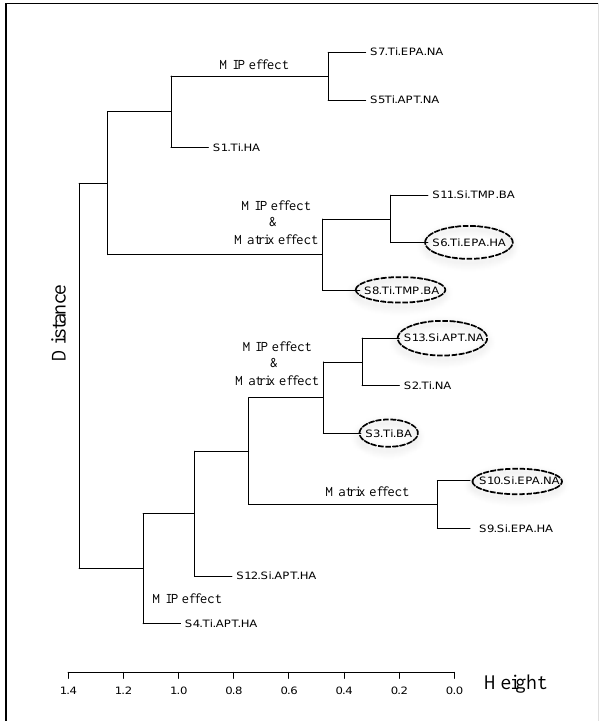
Figure 6. Hierarchical cluster dendrogram based on PC1-PC5 loading matrix of 13 sensors.